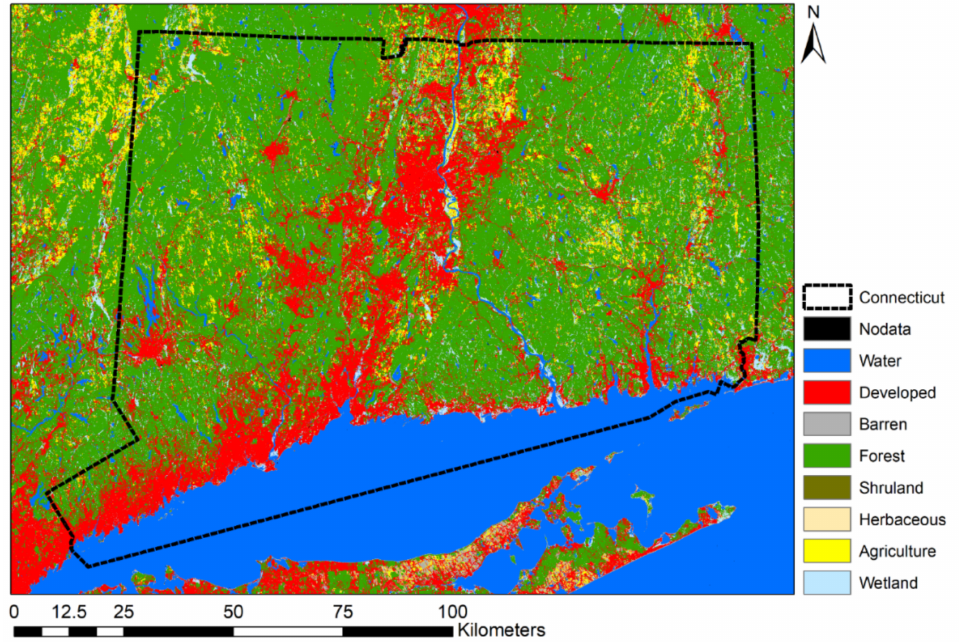
Figure 4. Previous land cover map (30 m) of Connecticut generated from the Continuous Change Detection and Classification (CCDC)